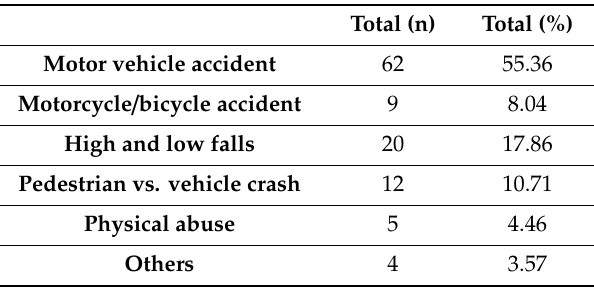
Table 3. Mechanisms of